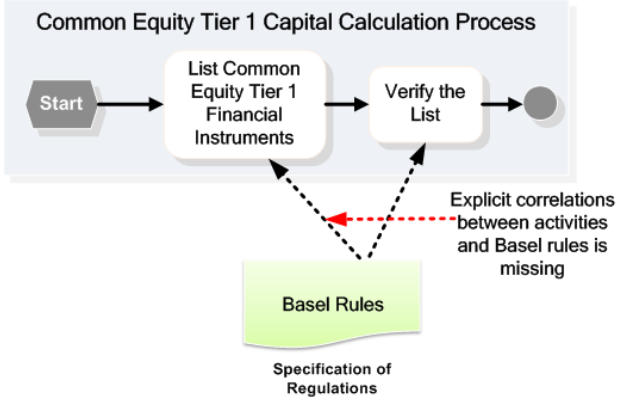
Figure 1. Common Equity Tier 1 Capital Ratio Calculation